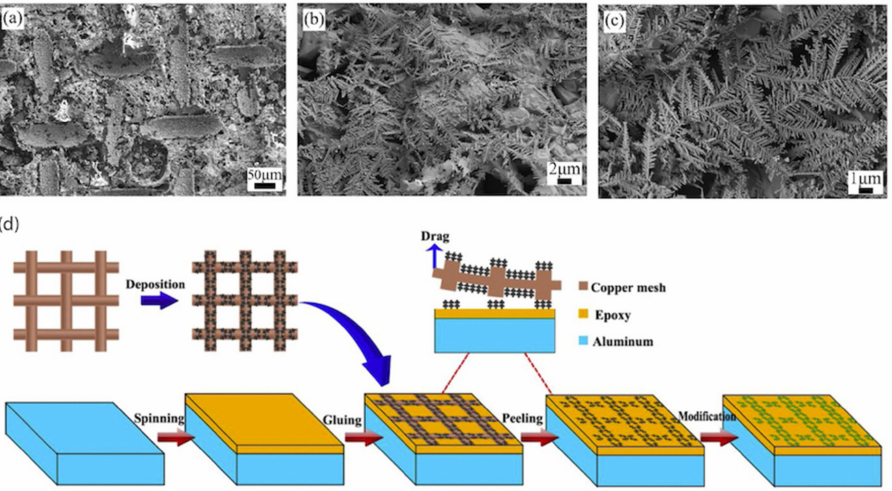
Figure 8. ( a – c ) SEM images of a modified aluminum surface at various magnifications; and ( d ) schematic illustration of the process involving spin-coating epoxy resin on aluminum (Reprinted from [35] with permission from